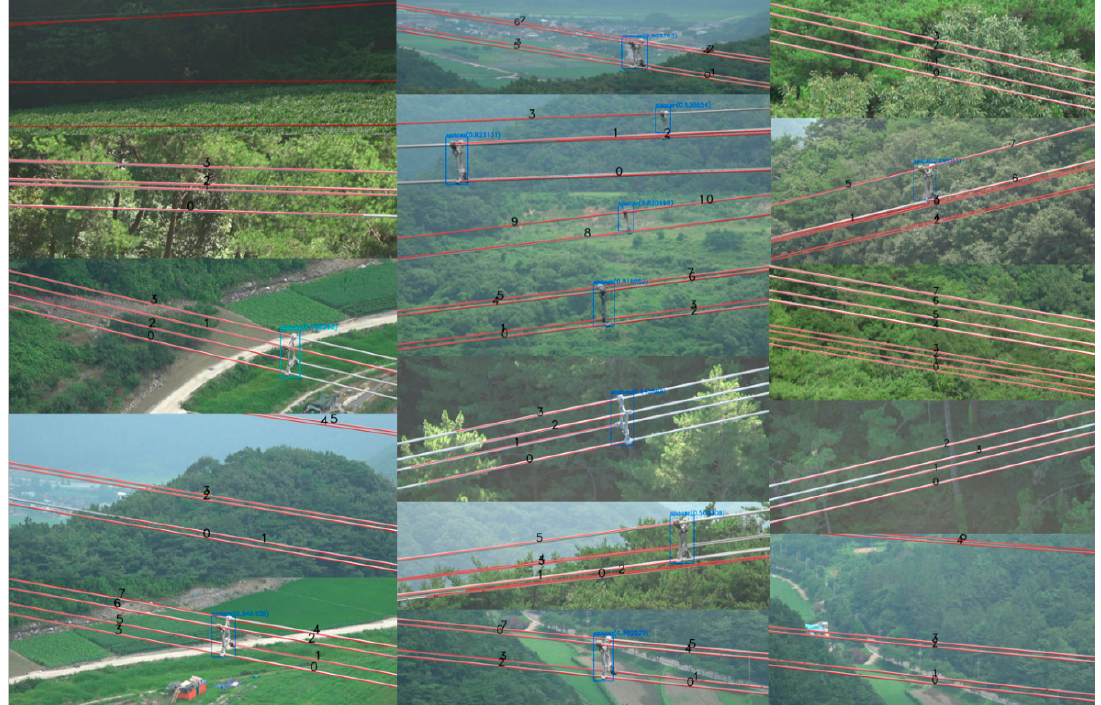
Figure 5. Power line detection results. The proposed power line detection algorithm shows robustness against cluttered background and different lighting conditions. Detected power lines are marked with red color, and labelled with ID numbers.